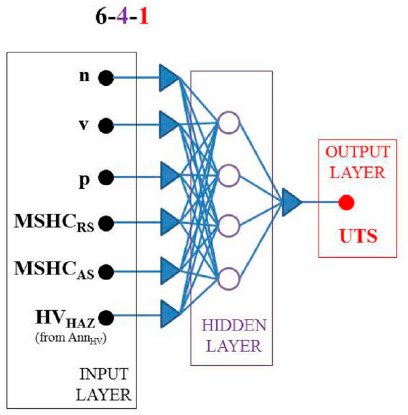
Figure 8. Back-propagation neural network used to foresee the Ultimate Tensile Strength.